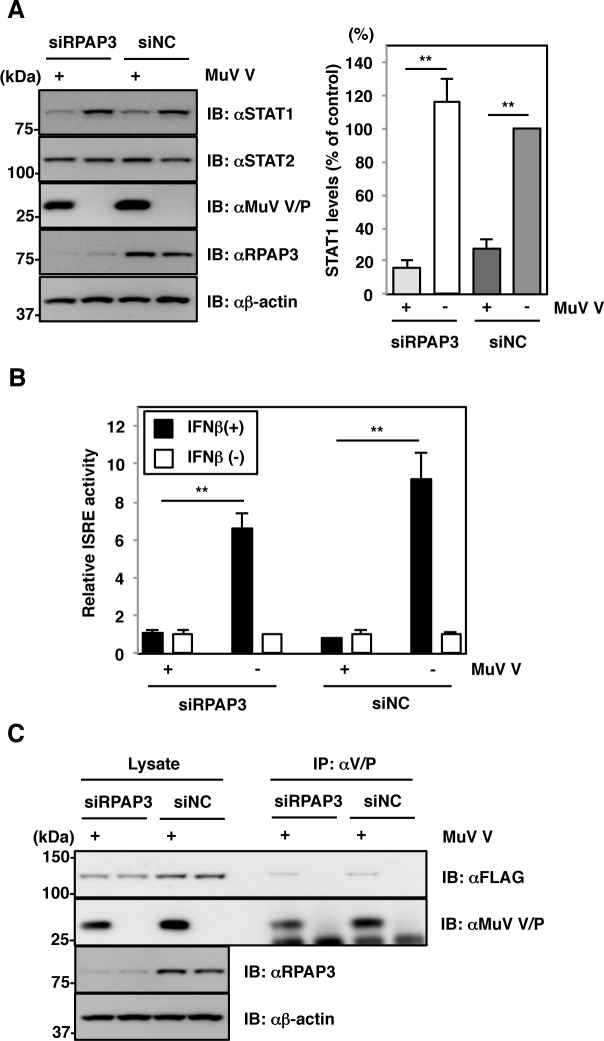
RPAP3 knockdown does not affect V protein function in anti-IFN responses.(A) 293T cells were co-transfected with pCAGGS-V or empty vector and siRPAP3 or siNC. At 72 h post-transfection, cell lysates were immunoblotted with the indicated antibodies. Relative STAT1 band intensities were normalized to β-actin level, and the relative expression of each protein based on levels in siNC-treated and empty vector-transfected cells are shown. (B) 293T cells were co-transfected with plasmids pISRE-luc13-p92, pRL-TK and pCAGGS-V or empty vector along with siRNA. At 72 h post-transfection, the cells were treated with IFNβ for 6 hr. Luciferase activities (based on levels in IFNβ-untreated cells) were quantified by normalizing to Renilla luciferase activities. (C) 293T cells were co-transfected with plasmids pEF-FLAG-MDA5 and pCAGGS-V or empty vector and siRNA. At 72 h post-transfection, cell lysates were immunoprecipitated with anti-MuV V/P antibody and immunoblotted with the indicated antibodies. Error bars indicate the standard deviations of triplicate wells. The significance of differences between means was determined using the Student’s t-test. **p<0.01.